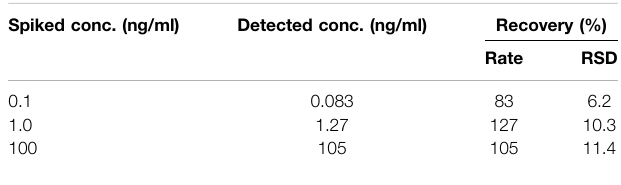
TABLE 3 | Recovery of spiked E2 in human serum. Spiked conc.